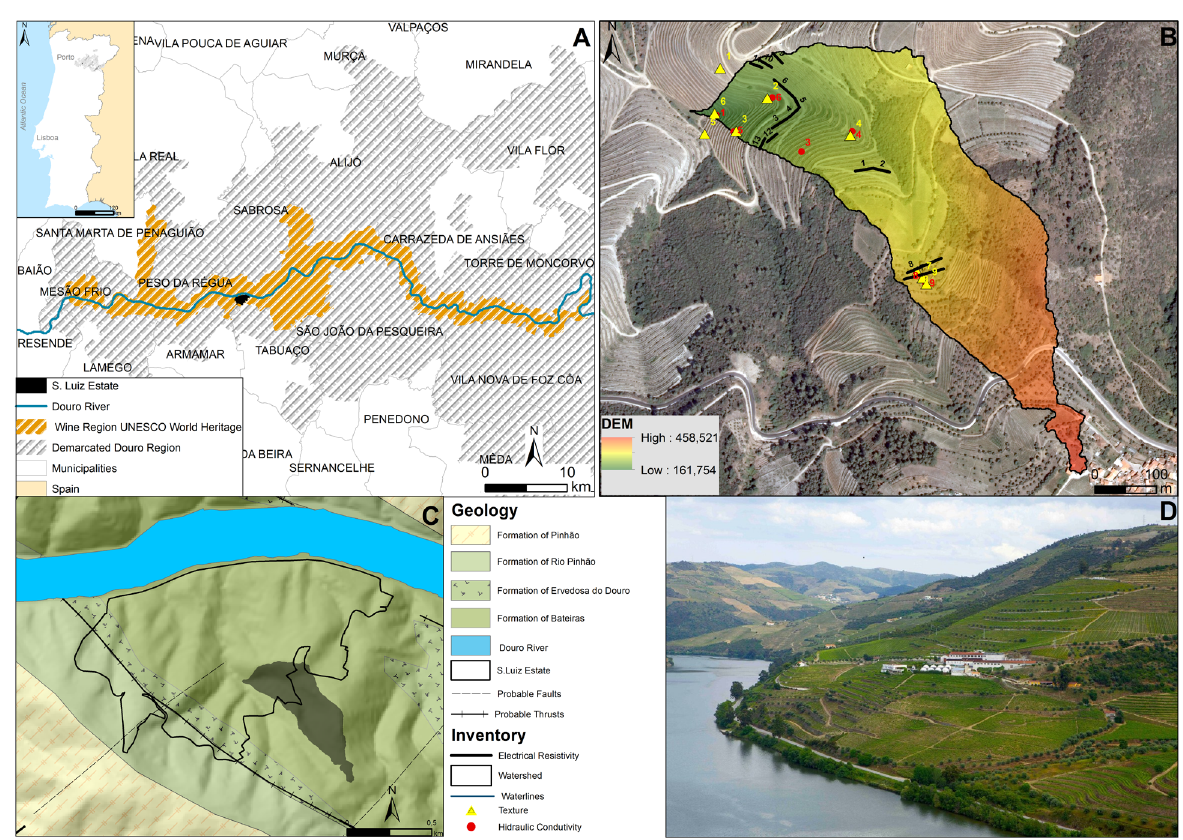
Figure 2: Study area framework. A. Location of Quinta de S. Luiz, in the spatial perimeter of the DDR ; B. Study watershed field monitoring; C. Lithology and tectonics; D. Overview of S. Luiz estate, on left margin of Douro